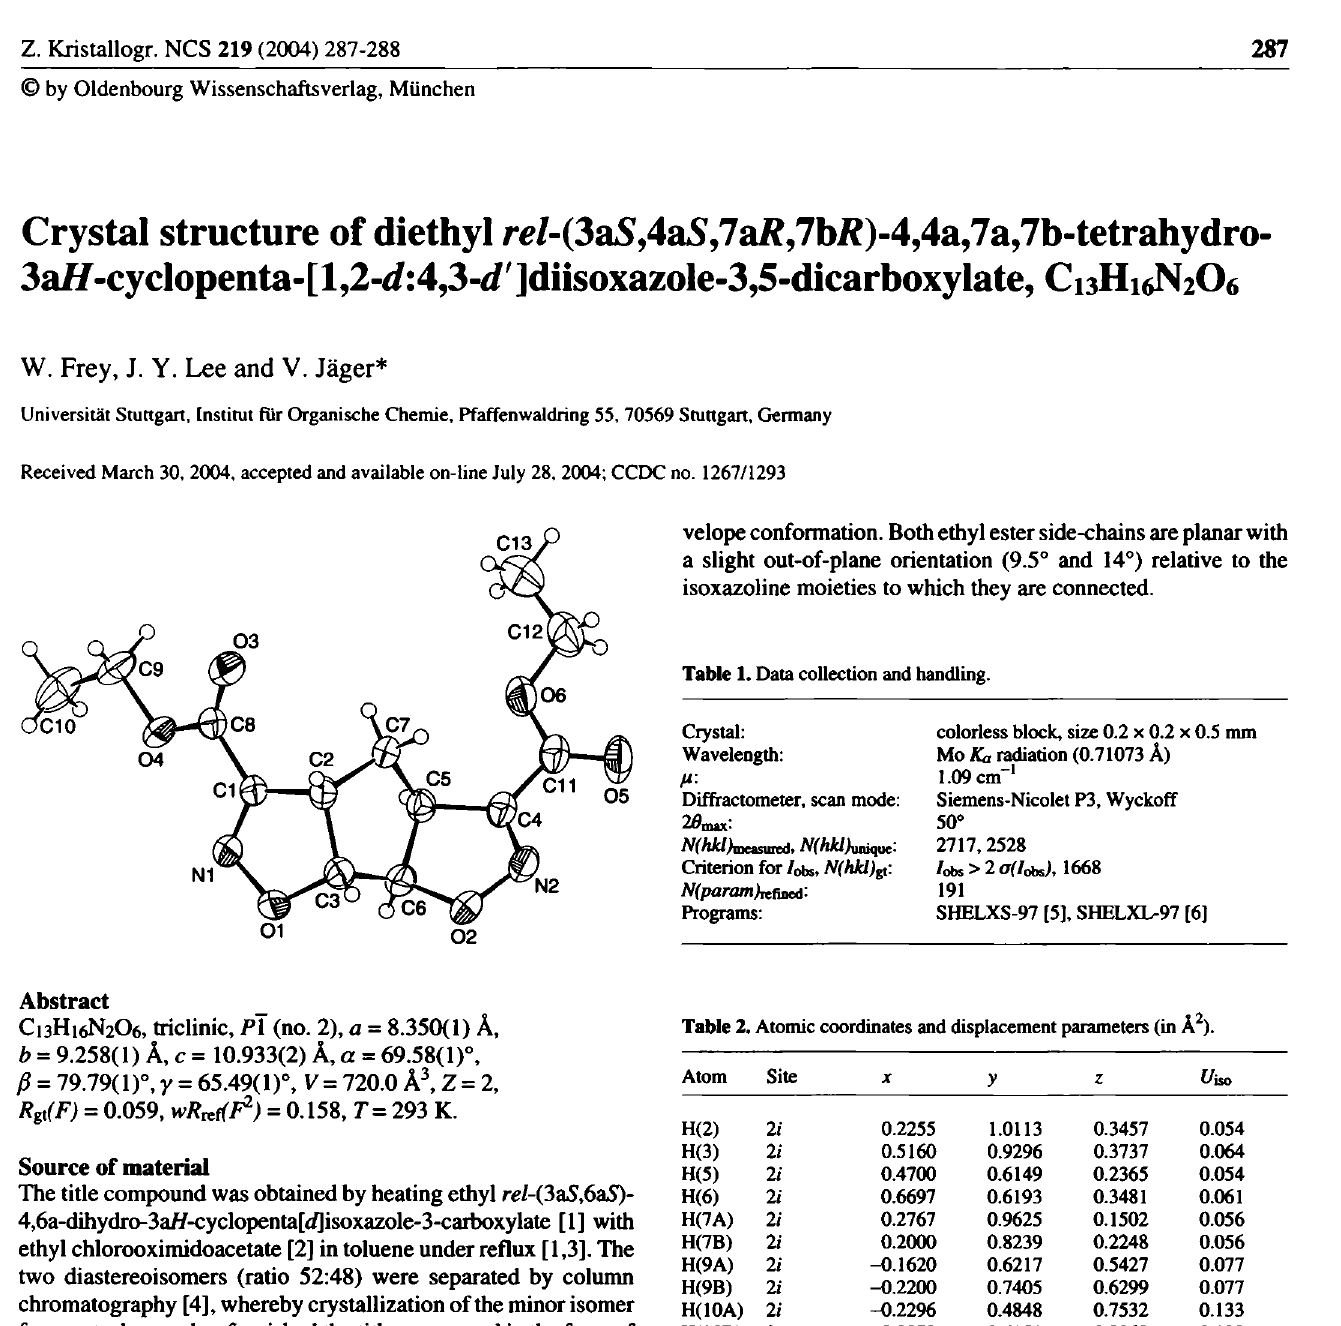
C13H16N2O6, triclinic, PI (no. 2), a = 8.350(1) A, b = 9.258(1) A, c = 10.933(2) A, a = 69.58(1)°, P = 79.79(1)°, y = 65.49(1)°, V= 720.0 A 3 , Z= 2,